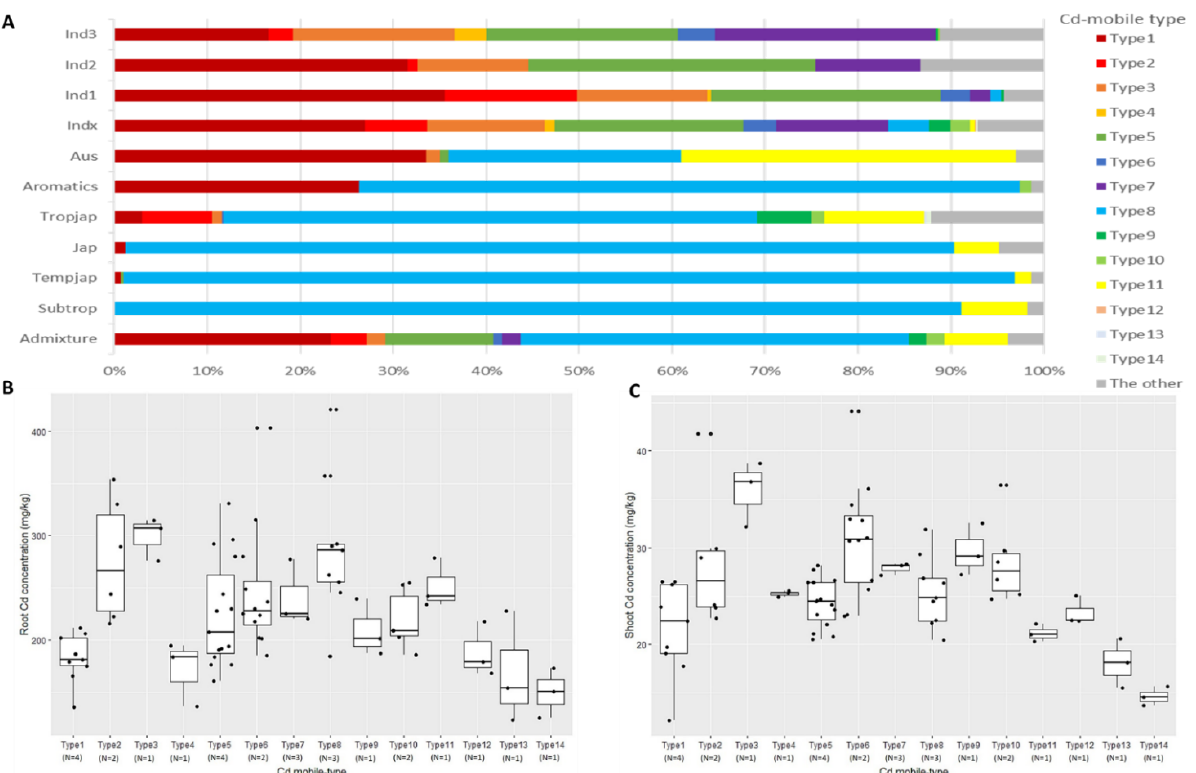
Figure 2. The distribution of 14 Cd-mobile types among the 3K-RGP accessions ( A ), and the Cd concentrations in roots ( B ) and shoots ( C ) in a hydroponic experiment. Ind1, ind2 and ind3 are three groups of indica rice, indx corresponds to other indica varieties, temp is temperate japonica , trop is tropical japonica , temp/trop and trop/temp are admixed temperate and tropical japonica varieties, japx is other japonica varieties, Aus is aus , inax is admixed aus and indica , Aromatics is aromatic and admixture is all other unassigned varieties. N, the number of varieties. Each variety has three replicates and labels the original points in the graph.